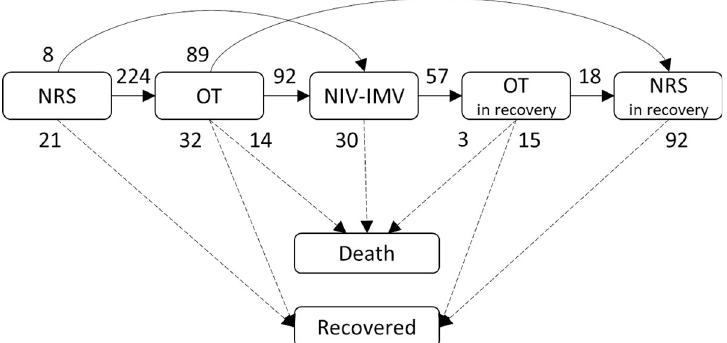
Fig 1. Representation of clinical pathways and number of observed changes of state. Notes: Arrows represent transitions between states and the number of observed transitions is reported. The dotted lines represent the final transitions of the study. NRS = No Respiratory Support; OT = Oxygen Therapy; NIV = Non-Invasive Ventilation; IMV = Invasive Mechanical Ventilation. 256 patients have started their hospitalization in the NRS state, 12 in the OT state and 3 in the NIV / INT state A total number of 64 patients with censored length of hospital stay were present: 3 in NRS, 9 in OT, 16 in NIV-IMV, 21 in OT in recovery, 15 in NRS in recovery.